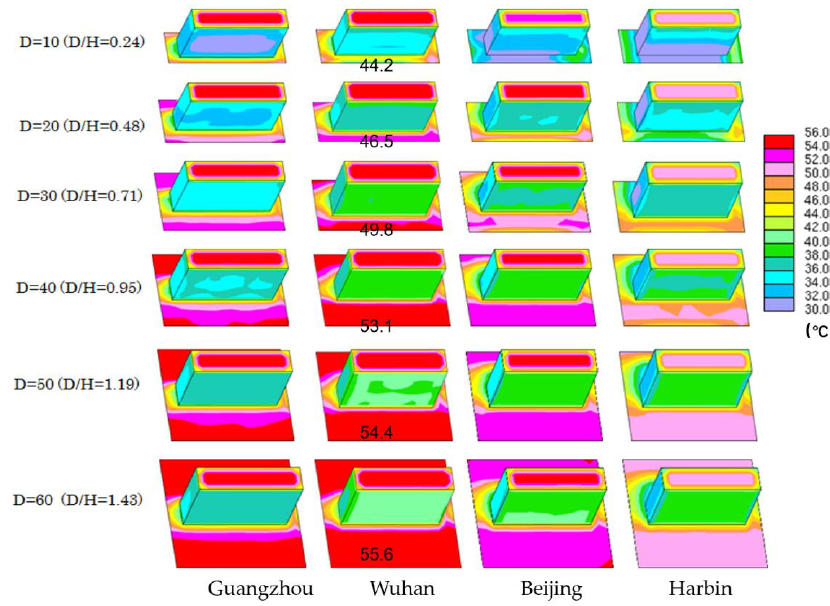
Figure 8. The distribution of outdoor surface temperature at 12:00.